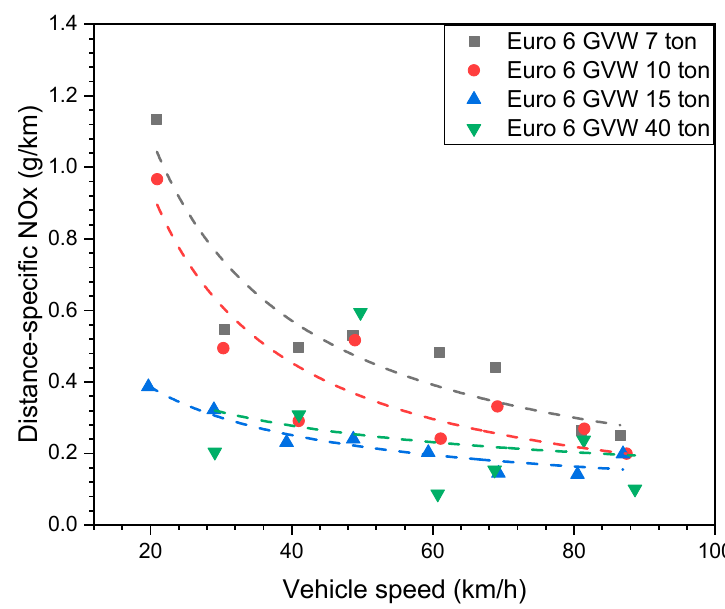
Figure 6. On-road NOx emissions from Euro 6 HDVs as a function of the average vehicle speed.